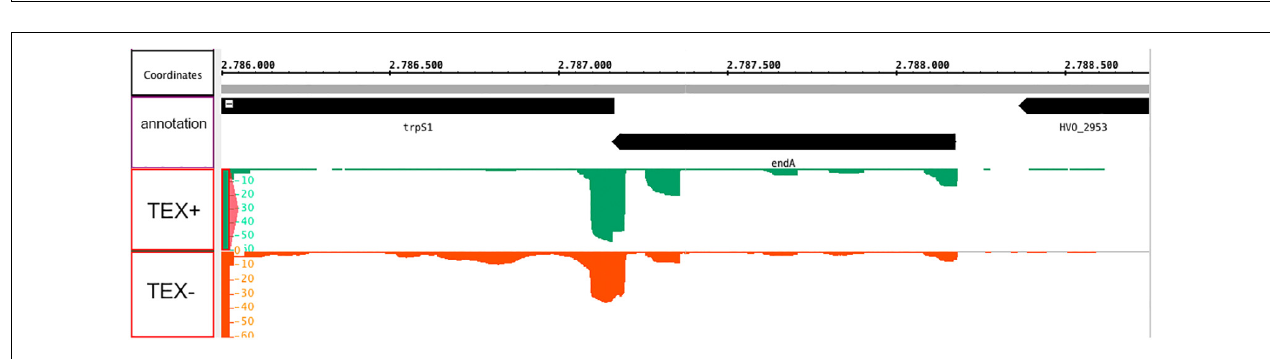
FIGURE 3 | Genomic location of the endA gene and transcription start site (TSS) analysis. The endA gene is encoded on the minus strand and overlaps the downstream trpS1 gene by four nucleotides. dRNA-Seq analysis was performed to identify TSSs in H. volcanii (Babski et al., 2016). Green signals: the isolated RNA was treated with terminal exonuclease (+TEX), red signals: the RNA was not treated with TEX (–TEX). Comparison of reads from both fractions allowed us to determine the TSSs. The genome sequence is shown in the middle (with the genomic location in nucleotides, annotated genes are shown in black bars). Green (+TEX) and red (–TEX) regions represent dRNA-Seq reads, and the height corresponds to the coverage (shown at the